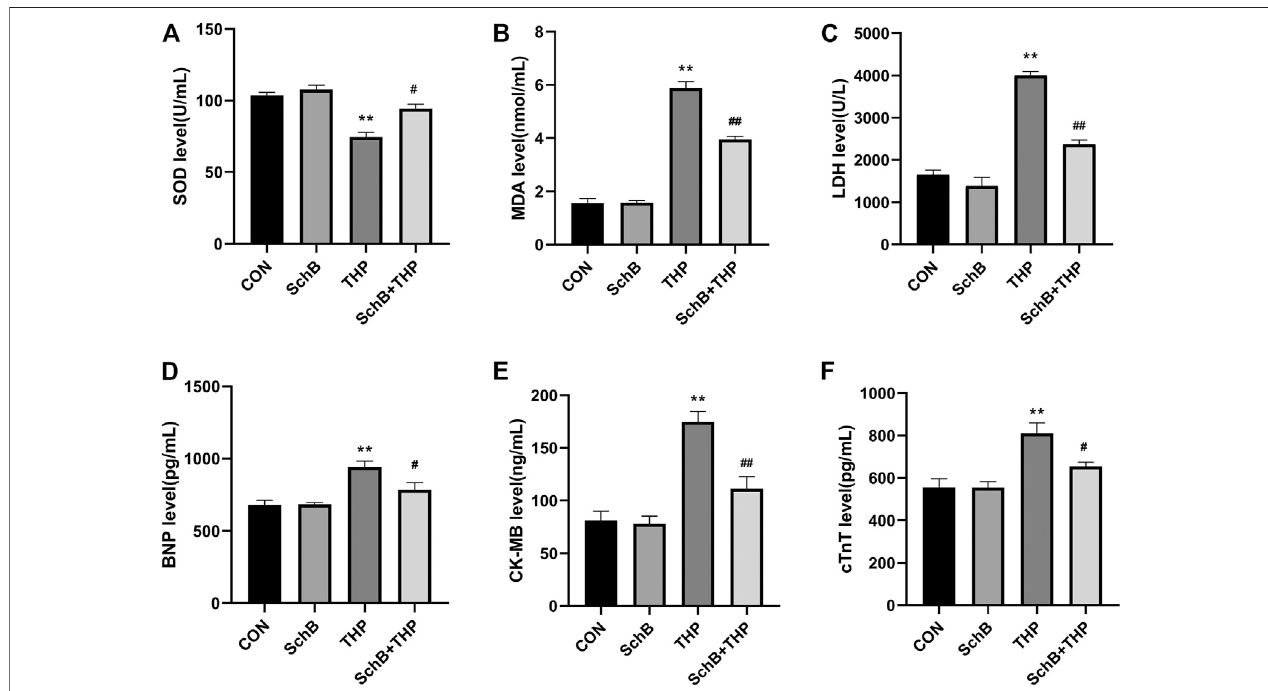
FIGURE 4 | SchB effectively improved the level of serum markers in heart injury induced by THP: (A) superoxide dismutase (SOD) levels, (B) malondialdehyde (MDA) levels, (C) lactate dehydrogenase (LDH) levels, (D) brain natriuretic peptide (BNP) levels, (E) creatine kinase MB (CK-MB) levels, and (F) cardiac troponin T (cTnT) levels. All values are mean ± SD. *p < 0.05 vs. CON , ** p < 0.01 vs. CON , # p < 0.05 vs. THP , and ## p < 0.01 vs. THP